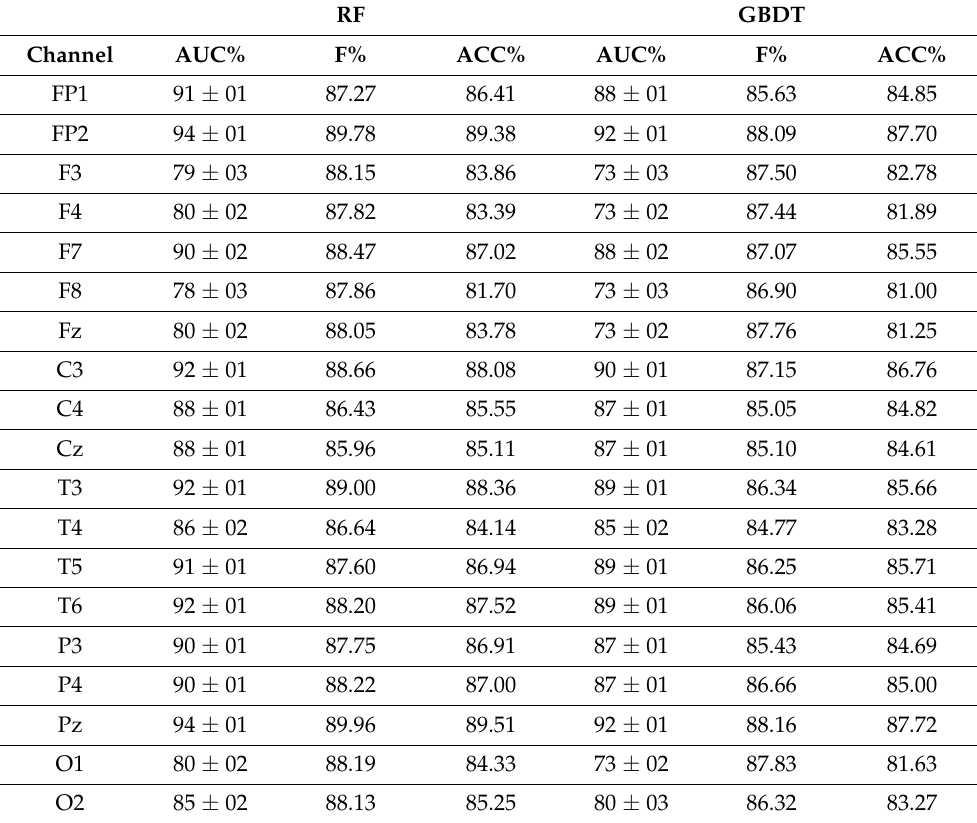
Table 7. Classification performance per channel using complexity measures and oscillatory